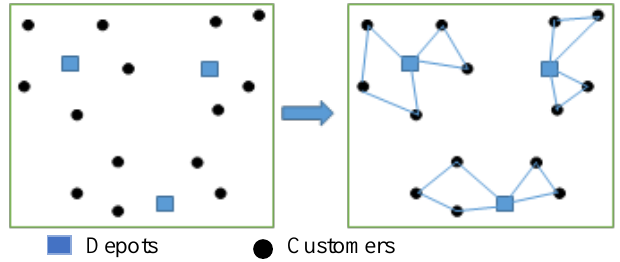
Figure 1. Multi-Depot Vehicle Routing